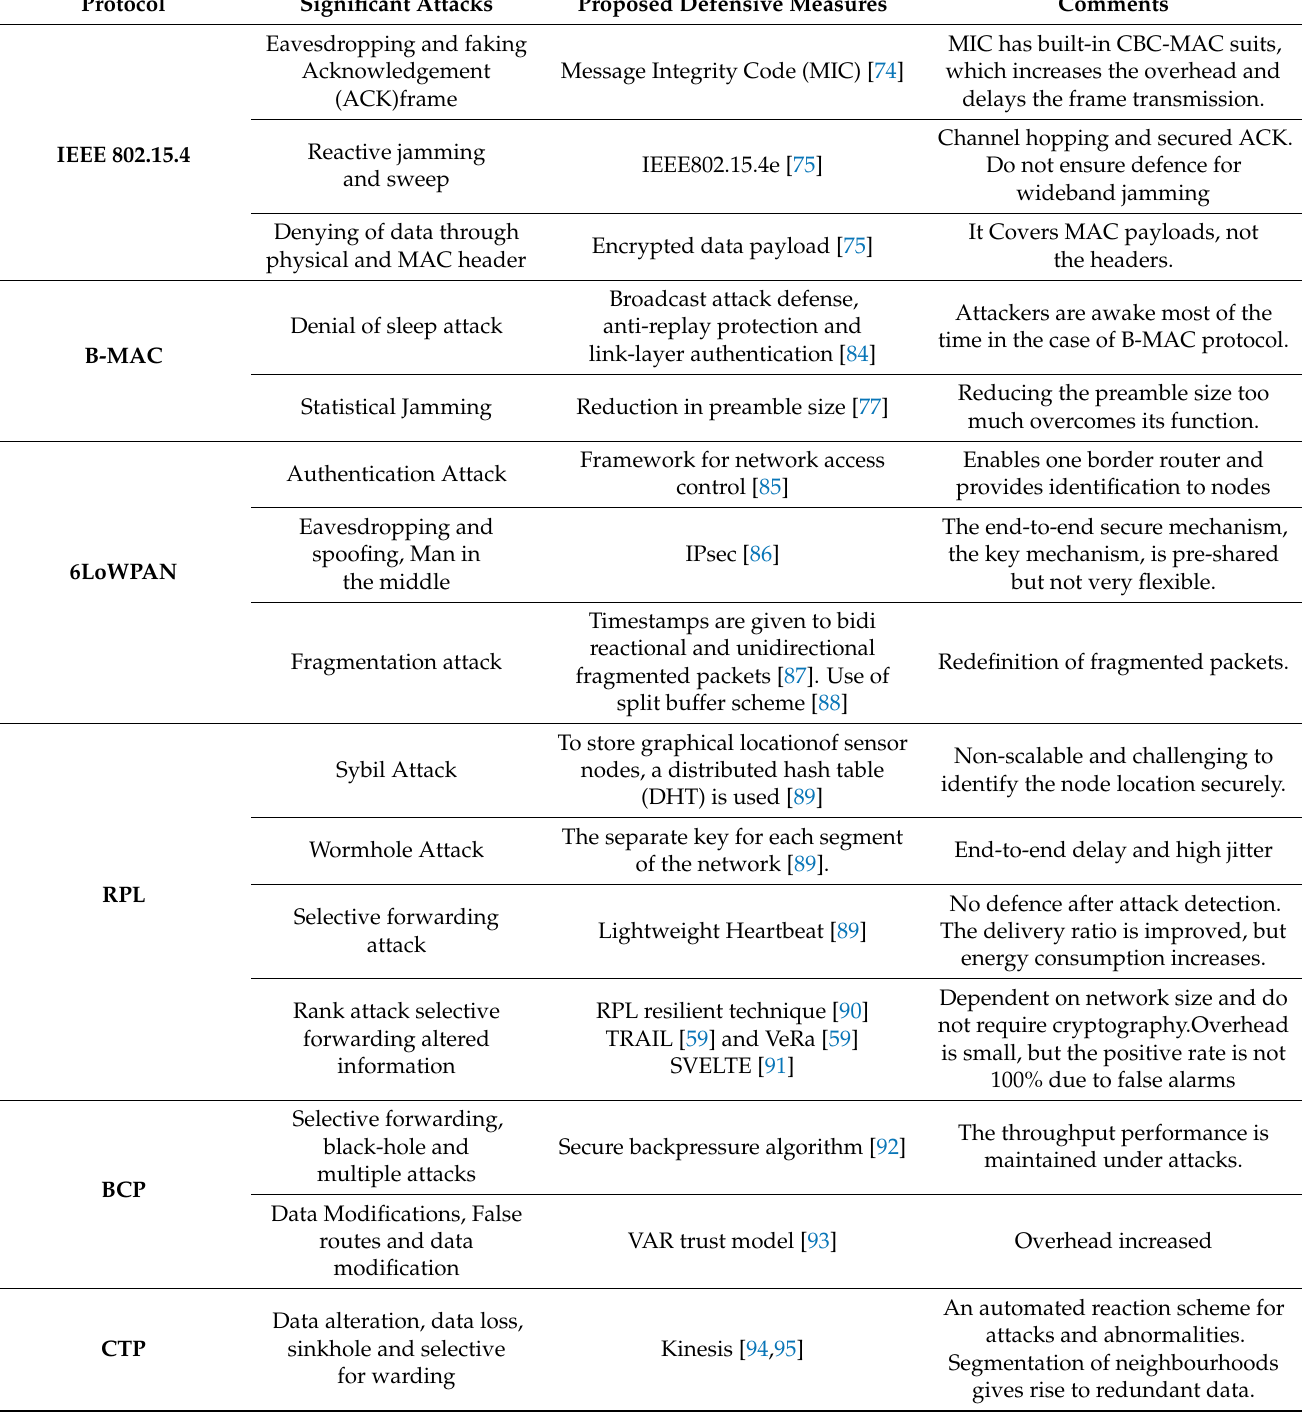
Table 6. Summary of attacks against various communication standards and protocols and existing defensive